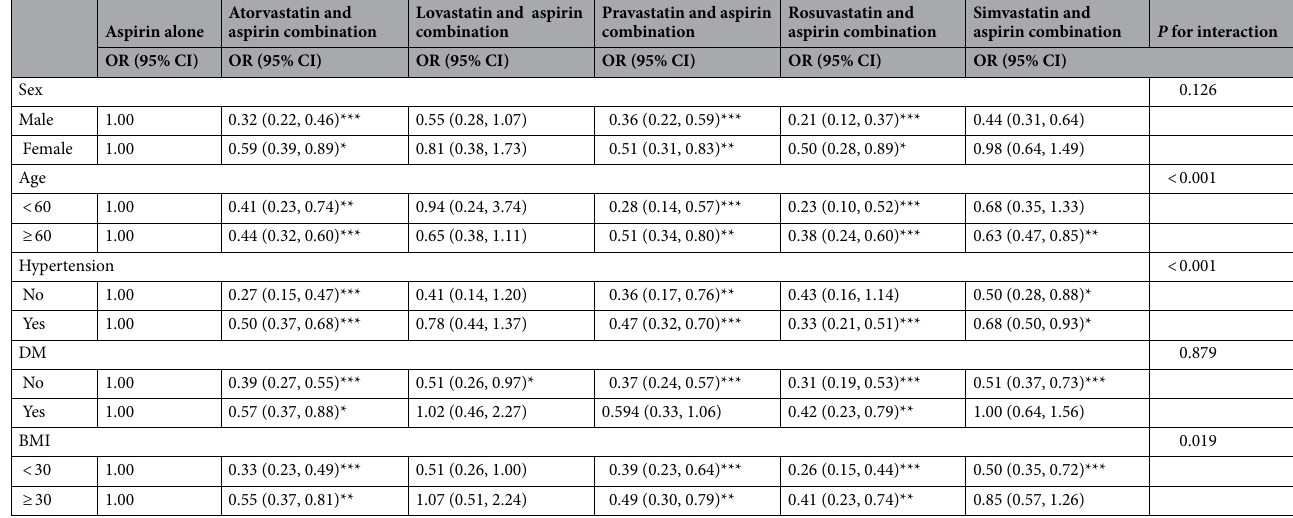
Table 4. Subgroups analysis for the associations of aspirin alone compared to aspirin plus statin with the prevalence of total CVD. Analyses was adjusted for age, gender, education level, race/ethnicity, marital status, family poverty-income ratio, hypertension, diabetes mellitus, smoker, alcohol user, body mass index, physical activity, total energy intake, high-density lipoprotein-cholesterol, total cholesterol, triglyceride, uric